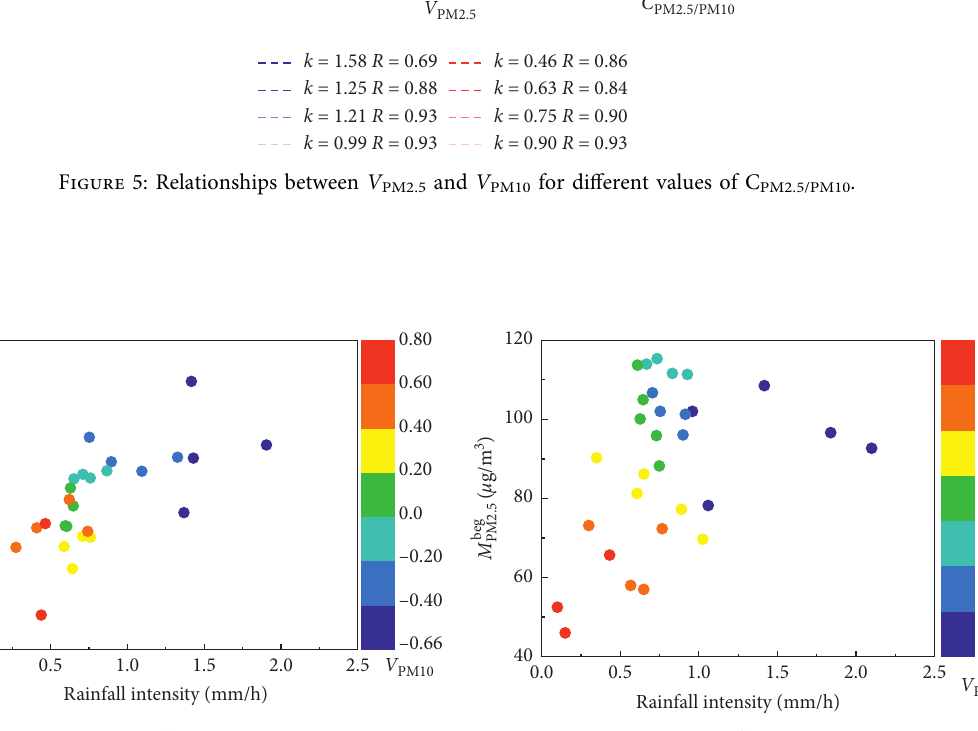
and M beg , average rainfall intensity, and mean values of V PM2.5 and V PM10 with intervals of PM2 . 5 PM10